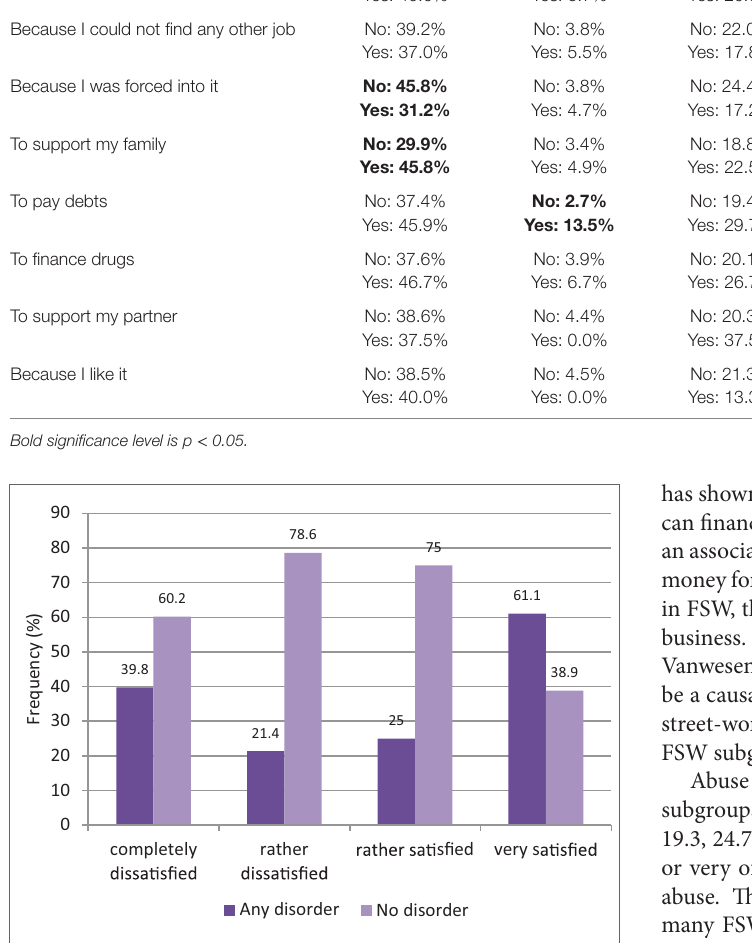
FigUre 2 | relationship between quality of life and occurrence of any mental disorder